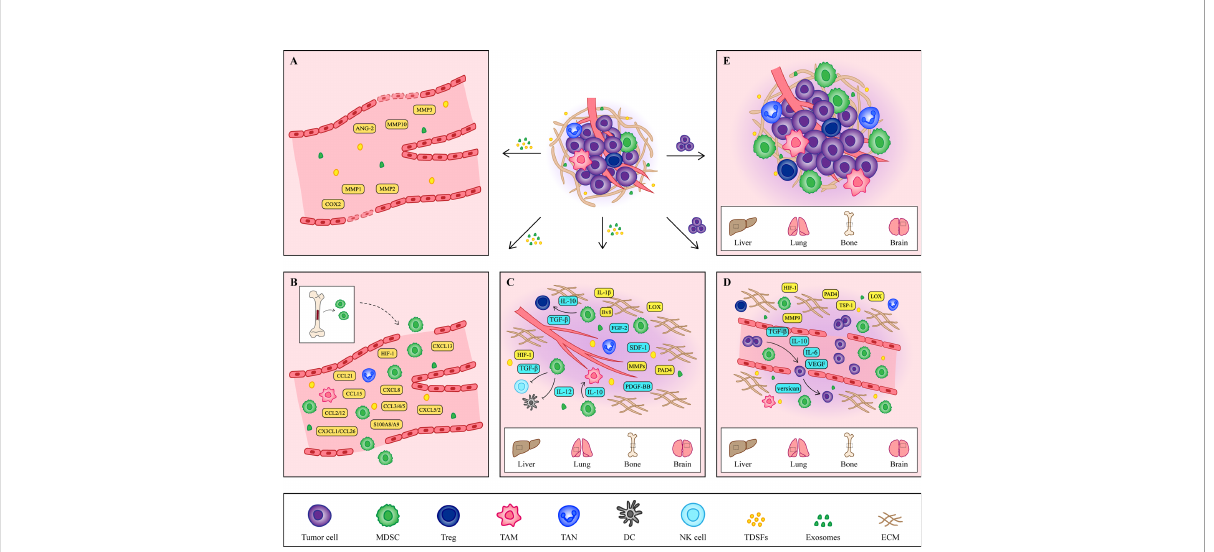
FIGURE 1 The formation of PMN. (A) Vascular leakage is the initial marker of PMN formation. Cytokines such as COX2, MMP1 and MMP2 secreted by primary tumors increase the permeability of endothelial cells and help the exudation of tumor cells. (B) Under the induction of hypoxic microenvironment and TDSFs, MDSCs and other immune cells are recruited to PMN, creating an excellent immune microenvironment for tumor cells. (C) At the same time, the ECM in the host organ began to change, providing a good environment for the growth of tumor cells. The accumulation of fi bronectin and the crosslinking of collagen I provide a platform for the adhesion of MDSCs. At the same time, MMPs promote angiogenesis and contribute to tumor cells intrusion. In addition, some cytokines secreted by MDSCs also contribute to the remodeling of ECM. (D) Tumor cells arriving at the host organ will enter a dormant state, which is regulated by cytokines secreted by tumor cells and MDSCs. When tumor cells wake up, they continue to grow. (E) The formation of the PMN is a comprehensive result of vascular leakage, MDSCs recruitment and ECM remodeling. The tumor cells shed from the primary site and colonized the host organ, eventually forming a distant